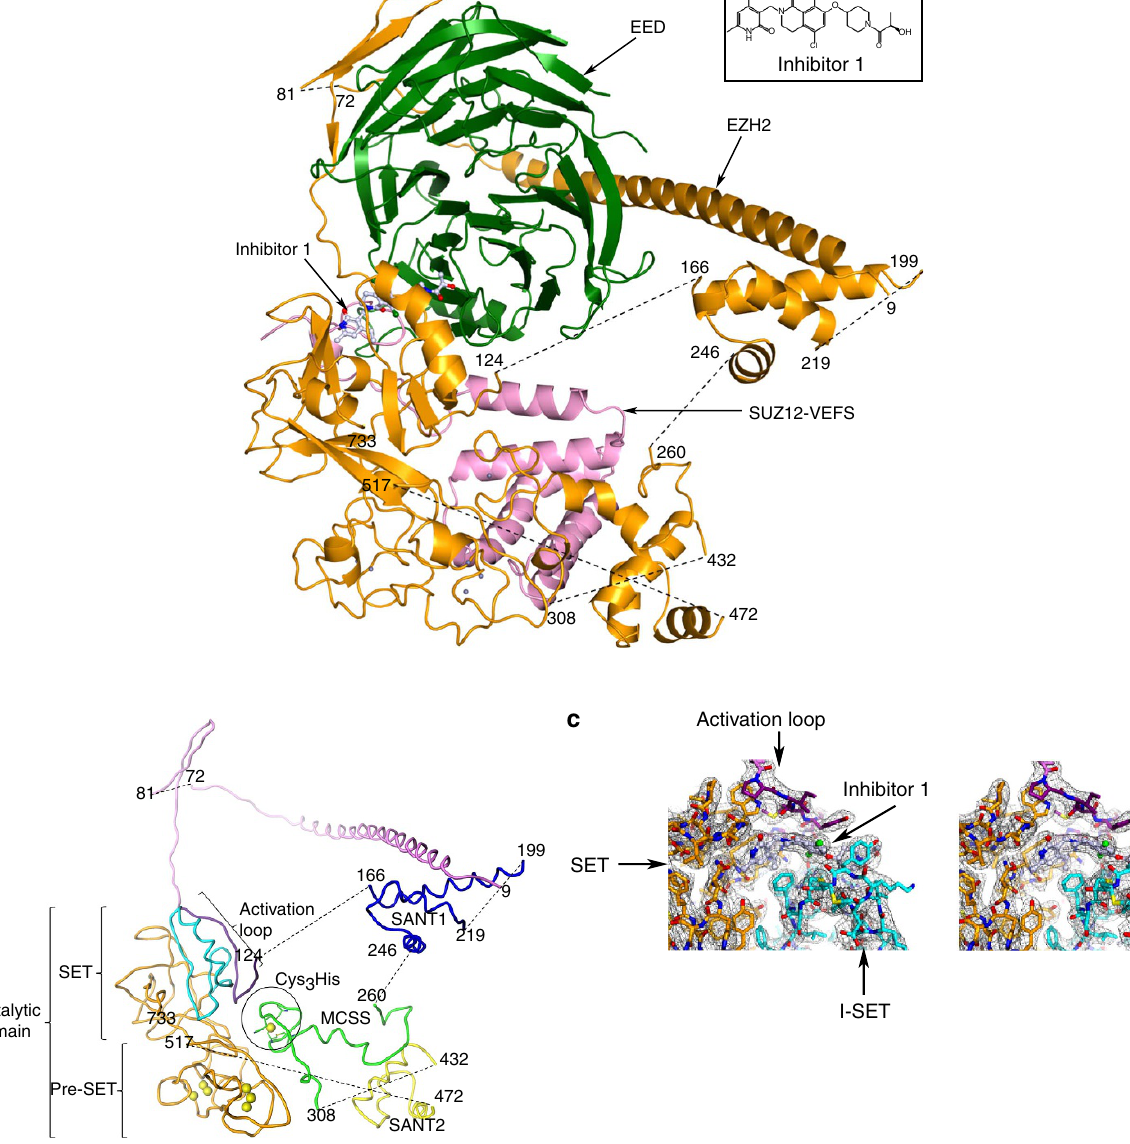
Figure 3 | Hs/Ac PRC2 co-crystal structure. ( a ) Complex structure with EZH2 (orange), EED (green) and SUZ12-VEFS (pink) in ribbon representation, and the inhibitor 1 in ball-and-stick. The dotted lines represent the disordered polypeptide chain of EZH2 not modelled in the structure. Zn atoms are shown as spheres. The inset shows the chemical structure of the inhibitor. ( b ) The subunit architecture of EZH2. Zn atoms are shown in CPK representation. The colour code is VIBGYO (of the rainbow colours, VIBGYOR) from the N- to the C-terminus. In addition, I-SETof the SETdomain is highlighted in cyan. ( c ) Stereo drawing of 2Fo-Fc electron density contoured at 1 s around the ligand-binding site. The ligand is shown in ball-and-stick representation, while the protein atoms are shown as sticks. Colour code is the same as in b : SET domain is shown in orange, I-SET region of the SET domain in cyan and the N-terminal activation loop is shown in indigo